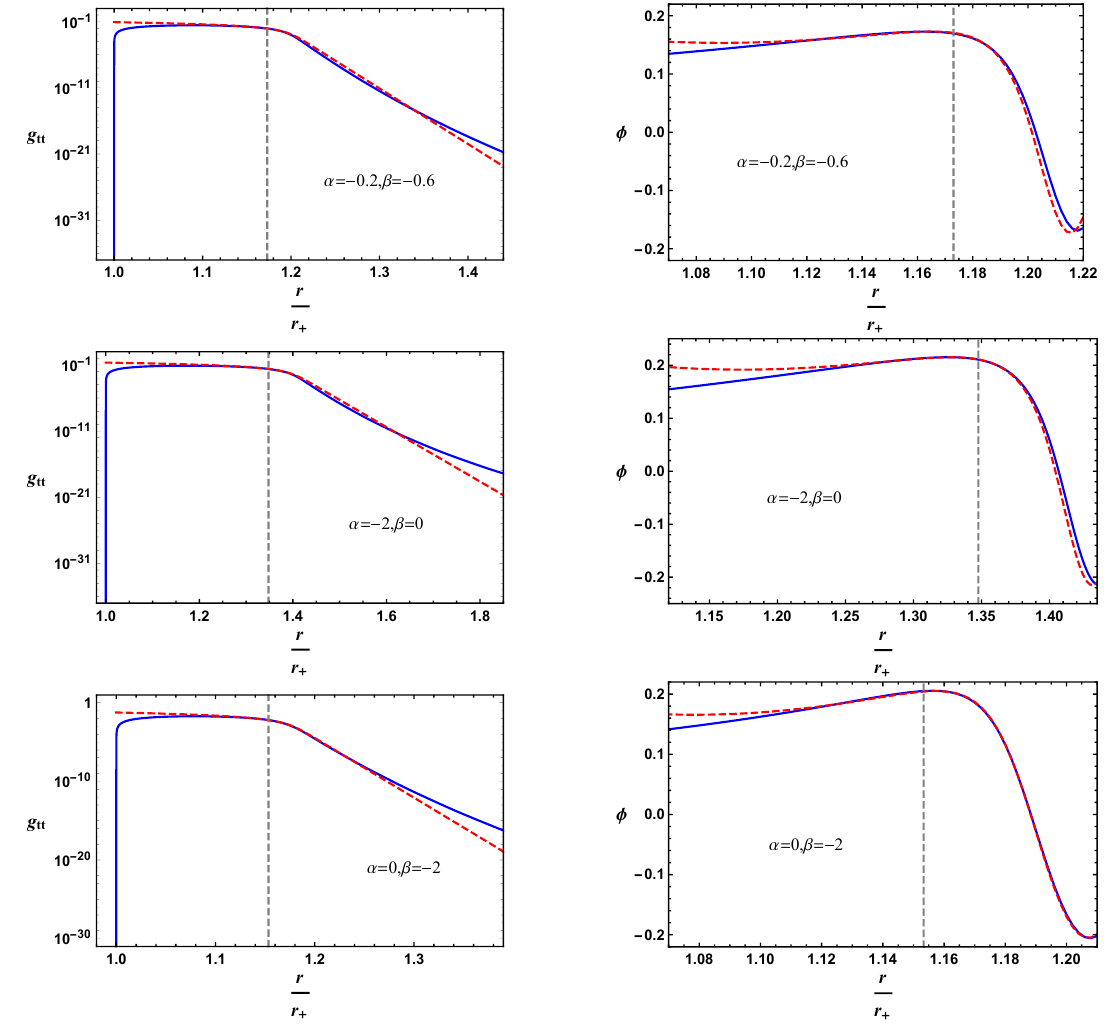
Figure 2 . Metric component g tt and scalar φ as a function of r near the collapse of the ER bridge. The solid blue curves are the numerical data and the red dotted curves are the fits to the relations (3.5) and (3.6). Here we take T/T c = 0 . 995 and κ/µ = 1 . The dashed vertical lines show the location of the would-be inner horizon r I